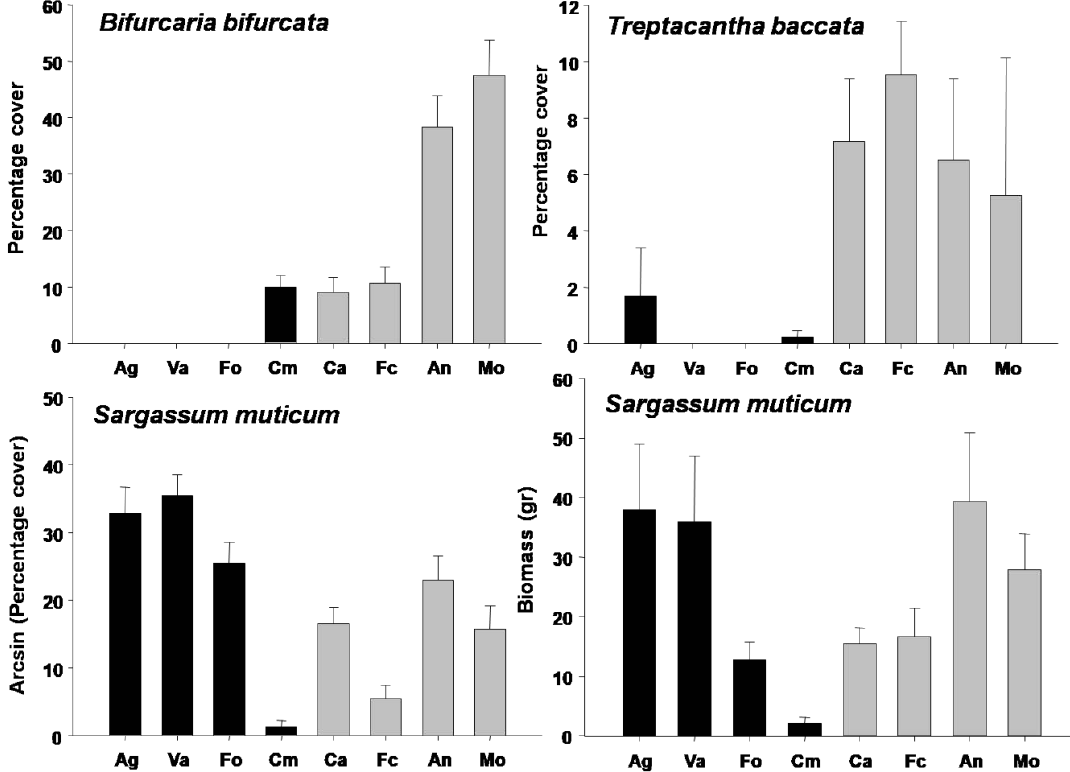
Figure 4. (+SE) percentage cover of individual taxa and biomass of S. muticum . Aguda (Ag), Valadares (Va), Foz (Fo), Cabo do Mundo (Cm), Carreço (Ca), Forte do Cão (Fc), Âncora (An) and Moledo (Mo). Significant differences in the abundance of B. bifurcata and T. baccata were found between urban and non-urban regions (Table 4).